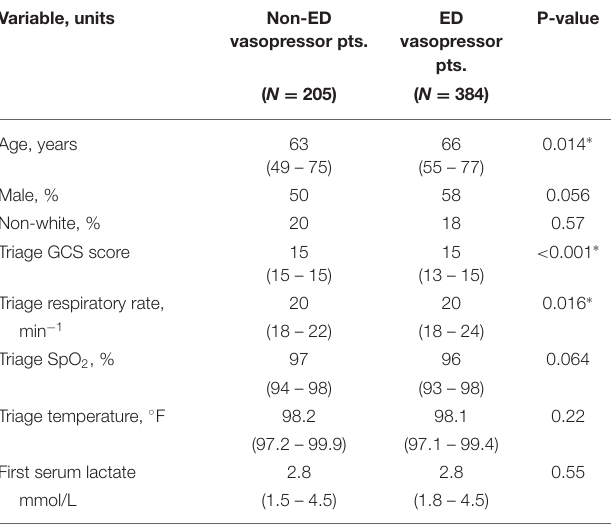
TABLE A1 | Clinical characteristics of the study cohort, compared across patients receiving vasopressors in the ED and patients not receiving vasopressors in the